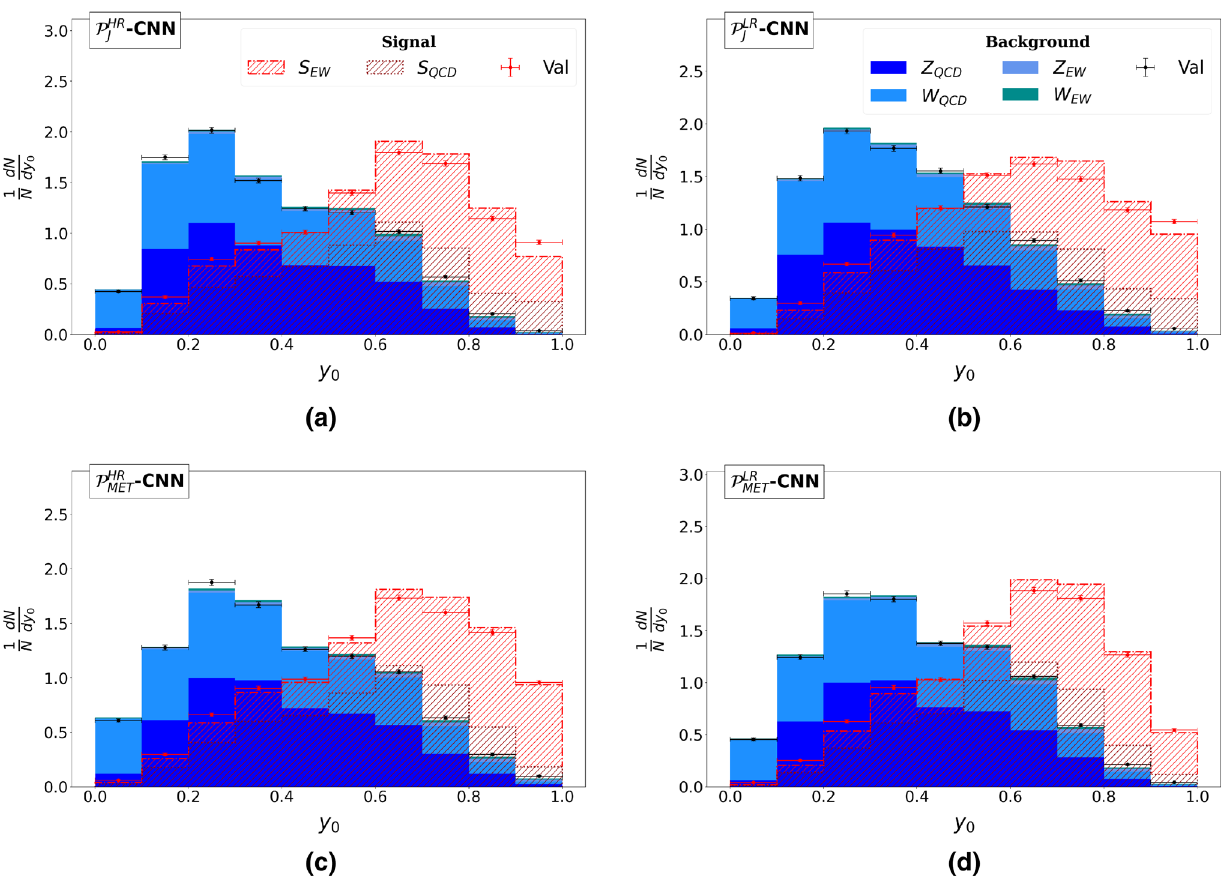
Fig. 11 Binneddistributionofthenetworkoutputfor a P HR